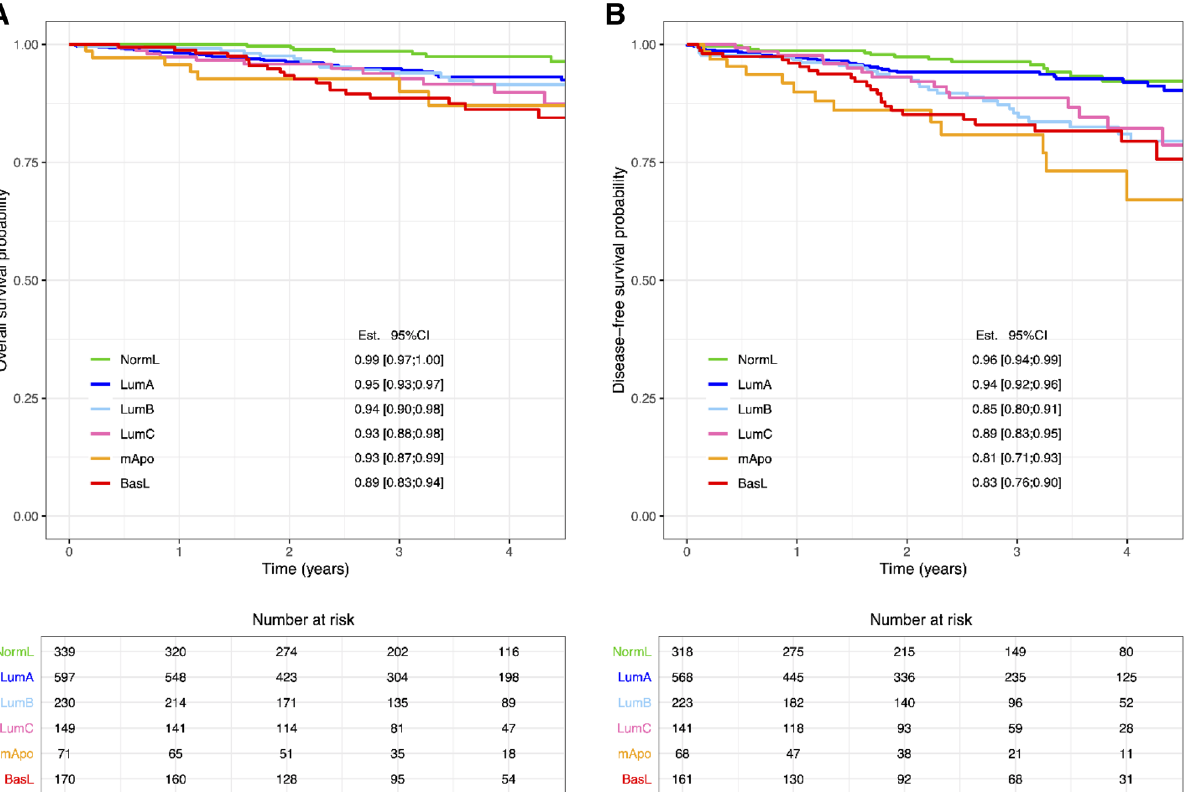
Figure 4. ( A ) shows the overall survival of the patient cohort according to the assigned molecular subtypes and ( B ) shows the disease-free survival. Molecular subtypes are color-coded; NormL (green), LumA (blue), LumB (light blue), LumC (pink), mApo (orange), BasL (red). The estimated survival probability (Est.) and the associated 95% confidence interval (95% CI) are shown at time = 3 years for each subtype. Figure created using R 32